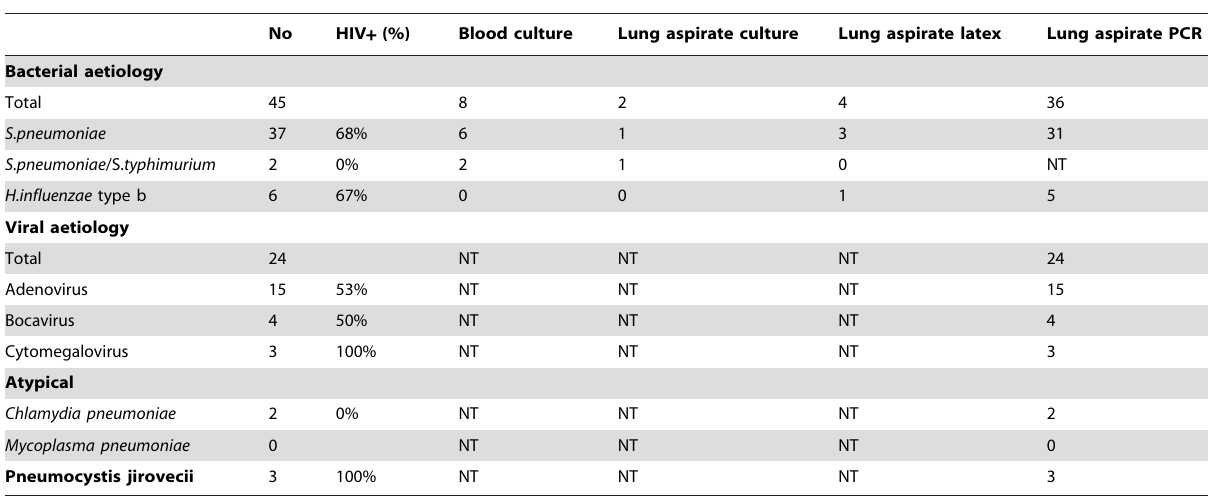
Table 2. Aetiology of radiologically confirmed pneumonia.